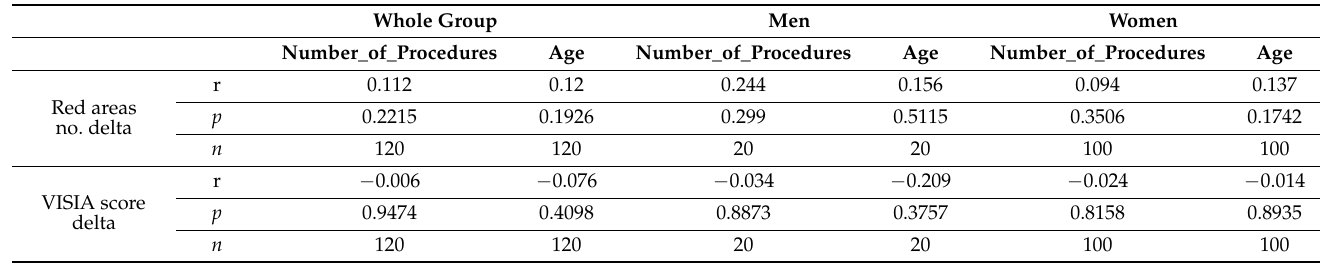
Table 2. Correlation analysis between studied parameters and number of laser procedures and age of persons regarding